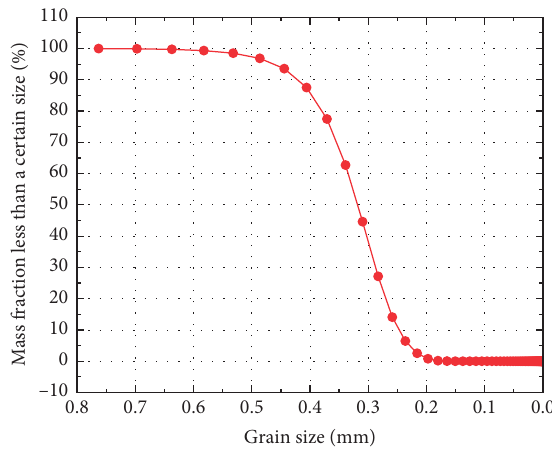
Figure 3: Particle size distribution curves of Tengger Desert sand.